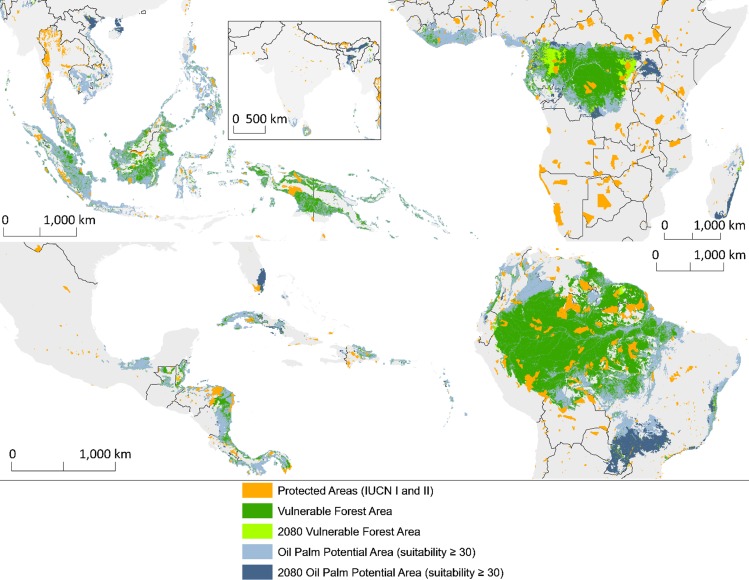
Vulnerable forest area.Present (dark green) vulnerable forest area and predicted vulnerable forest area in 2080 (light green). Vulnerable forest is MODIS VCF forest inside GAEZ suitable oil palm land, minus croplands and IUCN category I and II protected areas (orange). Deforested area suitable for oil palm is shown in each region at two times, present (light blue) and projected for 2080 (dark blue).